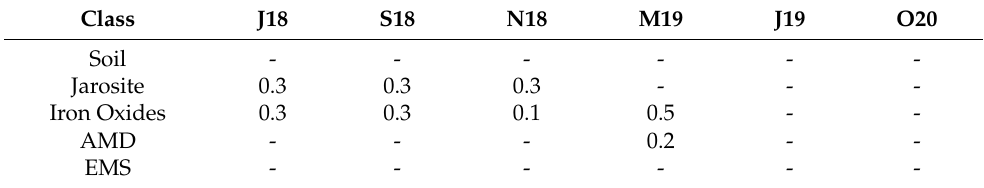
Table 4. Thresholds for Maximum Likelihood, where a - indicates that no threshold was